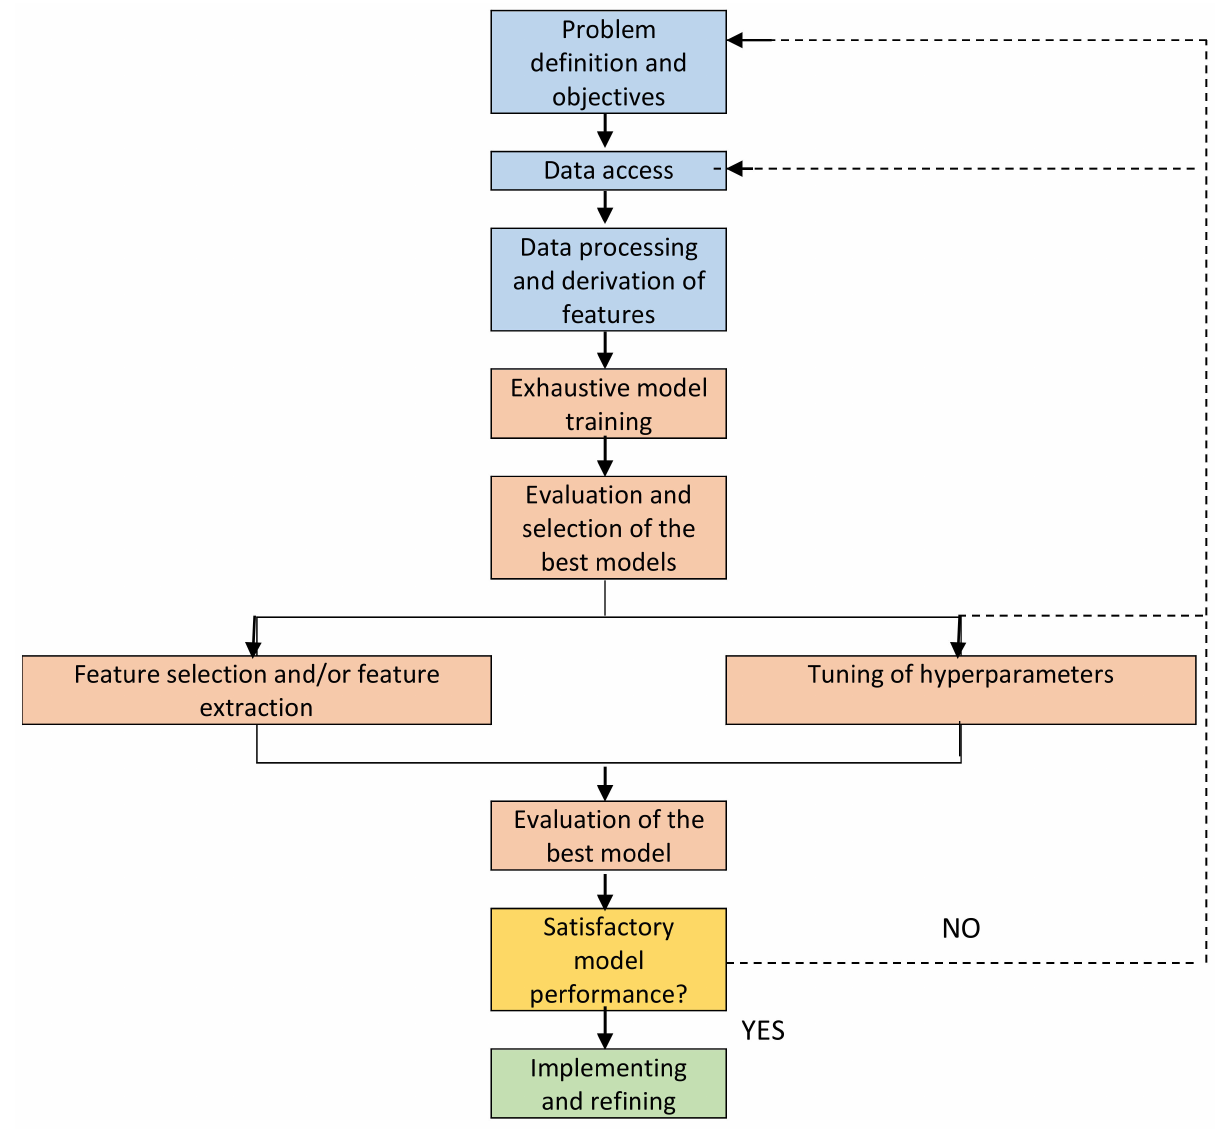
Figure 1. Machine Learning process workflow